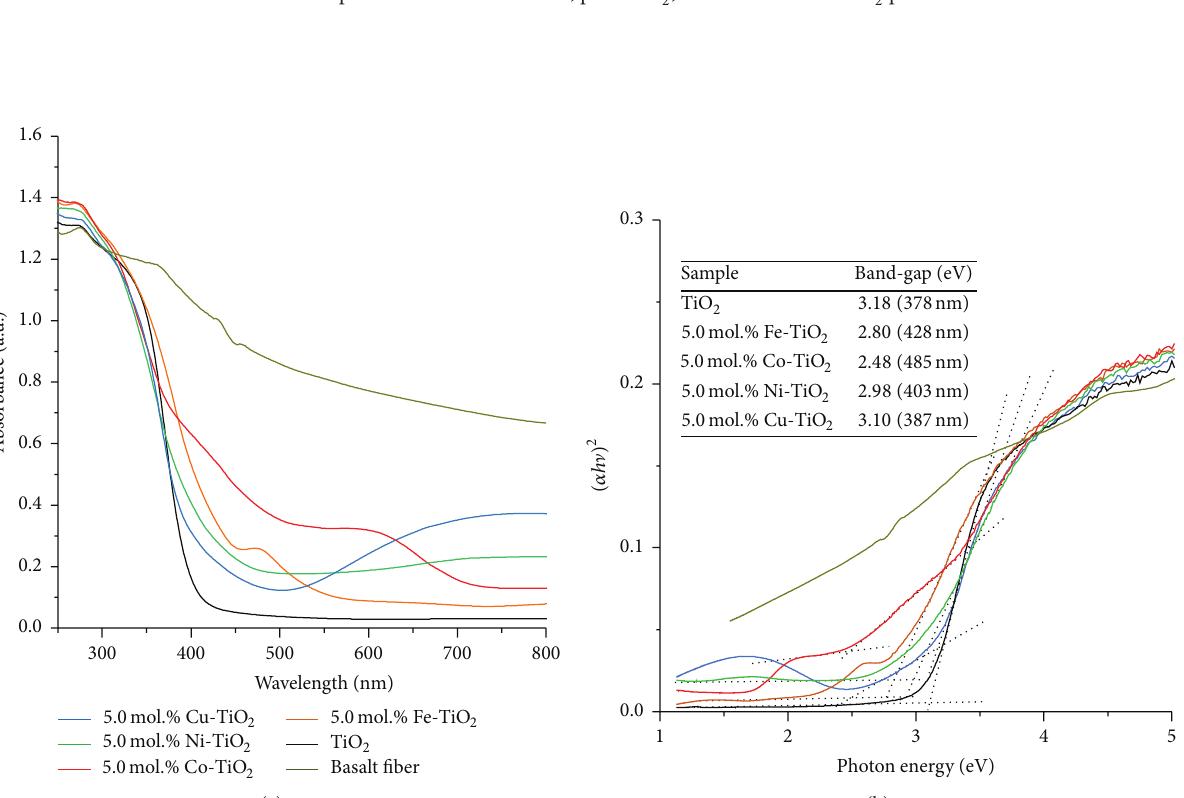
Figure 2: XRD patterns of the basalt fiber, pure TiO 2 , and 5.0 mol.% M-TiO 2 powders.